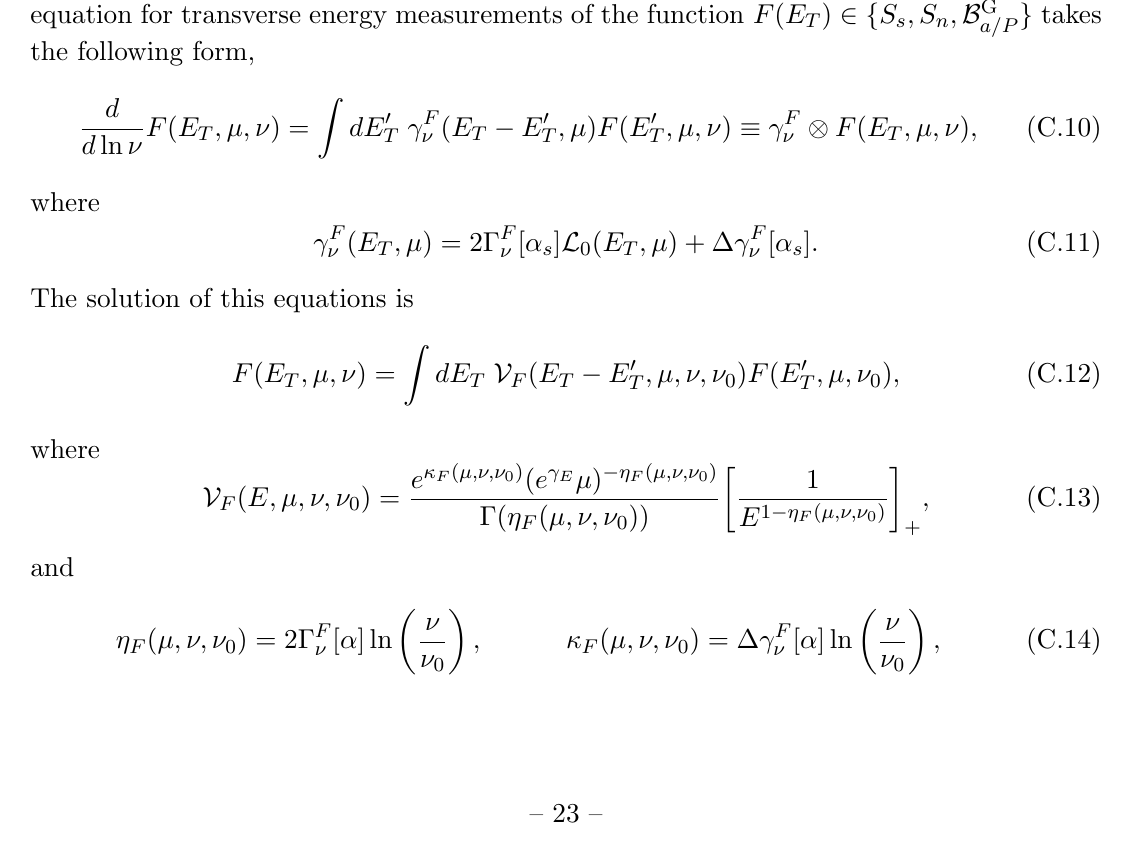
) and (cid:12) are the coe(cid:14)cients of the QCD (cid:12) 0 n